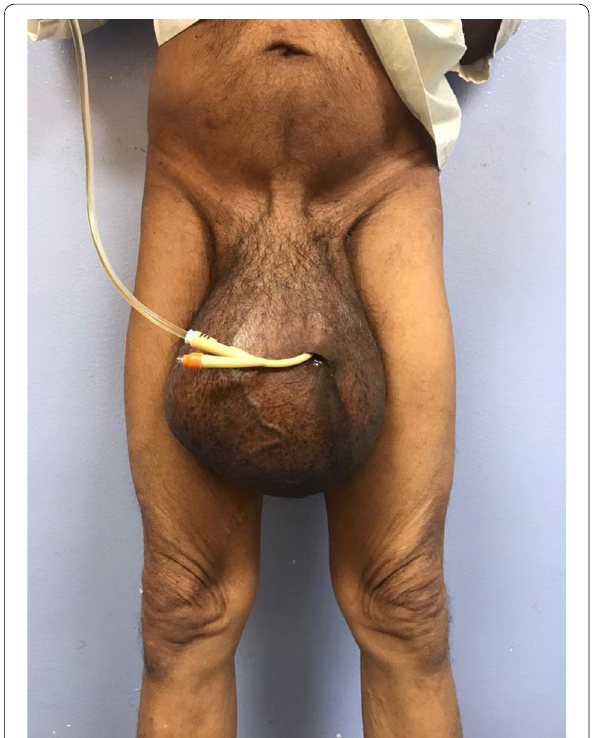
Fig. 2 Post-operative specimen of right orchidectomy, weighed